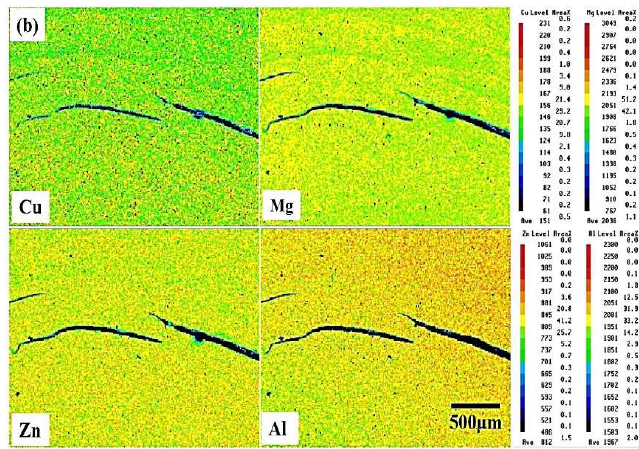
Figure 12. The fracture subsurface of the 1670-NA specimen near the crack: ( a ) the measurement of the hardness (HV) and ( b ) EPMA.